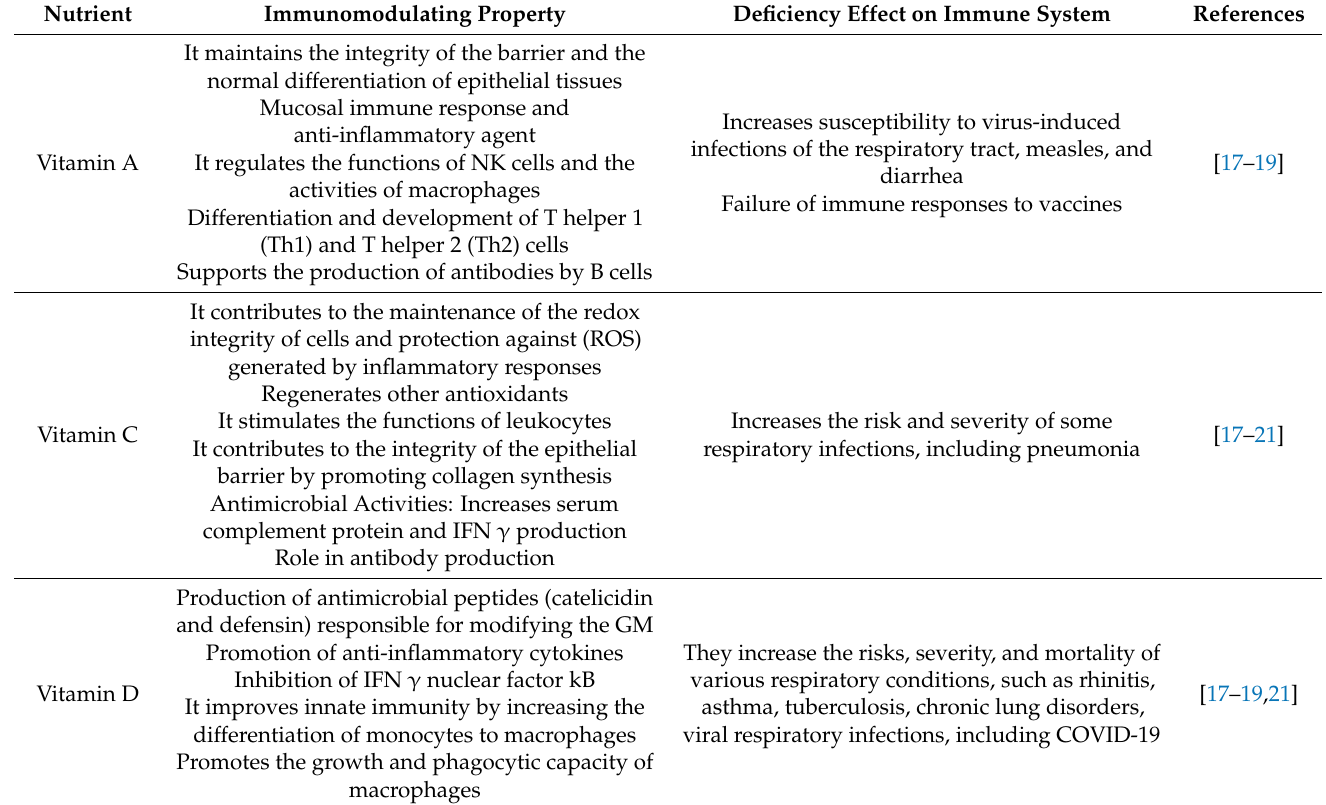
Table 2. Role of micronutrients in immunomodulation and their deficiency effects on immune